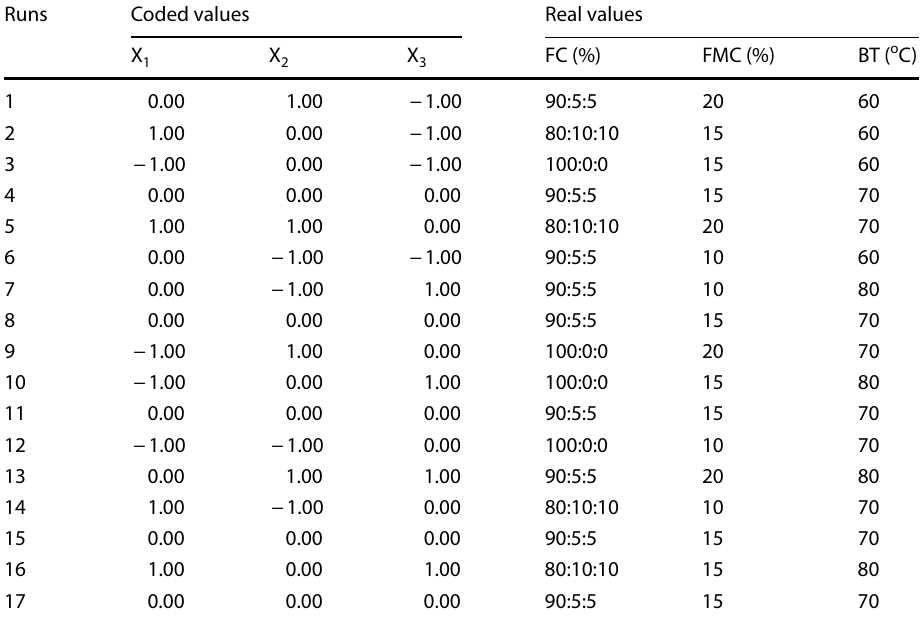
Table 1 Coded and real values for Box-Behnken